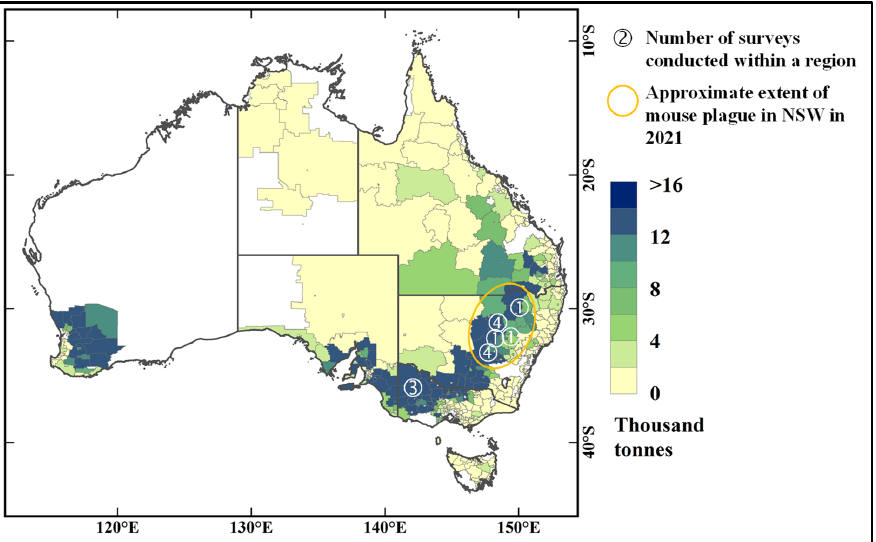
Figure 2. Approximate location of surveys conducted across southern and eastern Australia (n = 14) to assess mouse impacts on fodder storage, and approximate extent of the mouse plague that affected NSW through 2021 over a map showing fodder production. Source: Base map kindly provided by Randall Donohue (CSIRO, Land and Water) with data from Australian Bureau of Statistics [45].